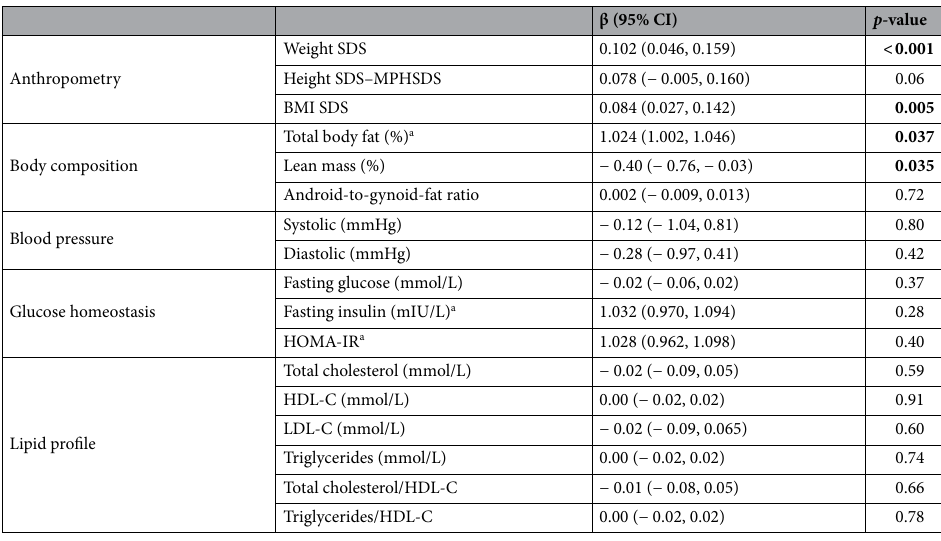
Table 5. Clinical outcomes at the 7-year follow-up in the offspring (n = 52) in association with maternal body mass index (BMI) in mid-gestation. Data are β coefficients and 95% confidence intervals (CI) derived from general linear models, including maternal body mass index (BMI) in mid-gestation, adjusted for child’s sex, age, and trial group allocation. HDL-C, high-density lipoprotein cholesterol; HOMA-IR, homeostatic model assessment of insulin resistance; LDL-C, low-density lipoprotein cholesterol; MPHSDS, mid-parental height standard deviation score; SDS, standard deviation score. p -values for statistically significant associations (at p < 0.05) are shown in bold. a Back-transformed β coefficients represent the proportional change in the outcome in association with maternal